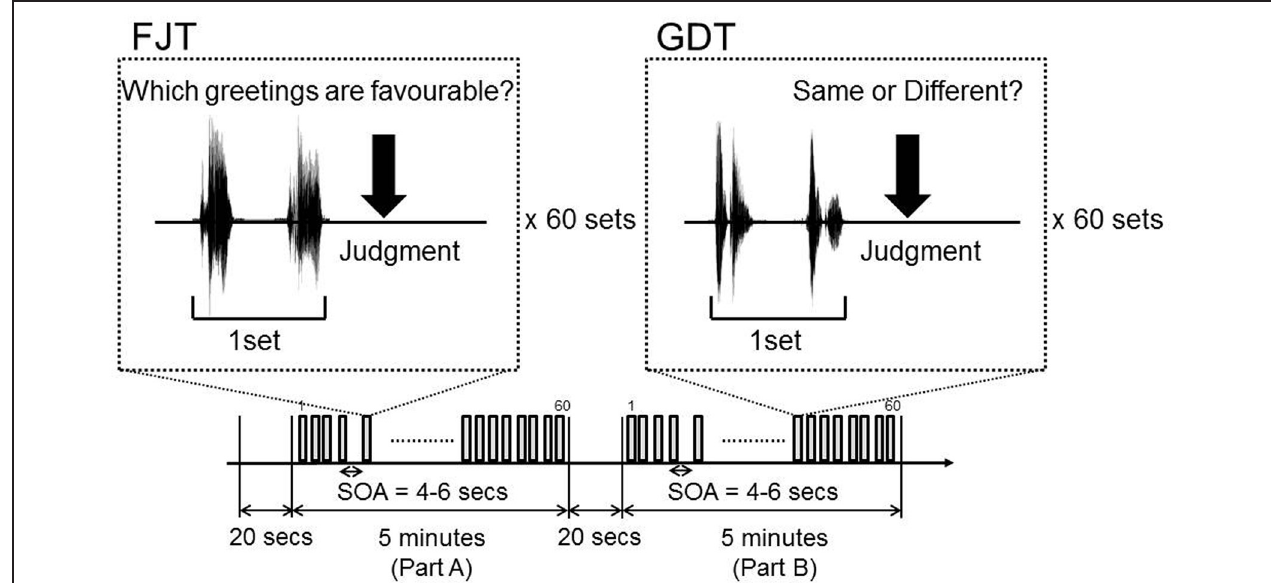
FIGURE 1 | Experimental design of fMRI Part A is Favorability Judgment Task (FJT). Part B is Gender Discrimination Task